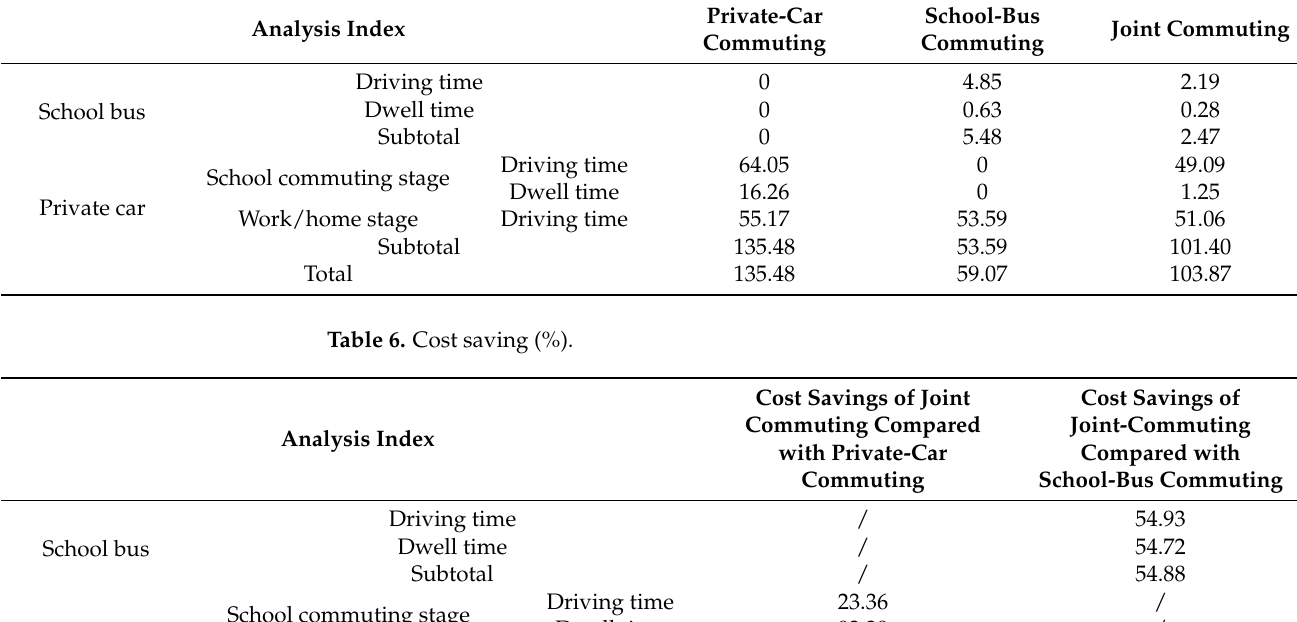
Table 5. Travel cost analysis of various modes in the joint-commuting model (h).